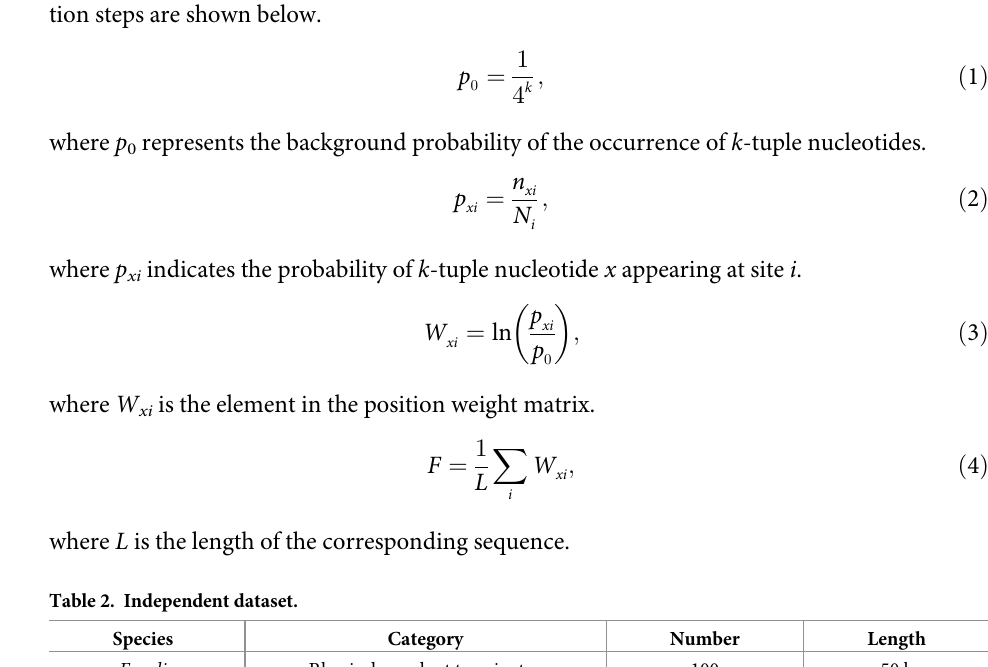
“~” represents approximately equal.